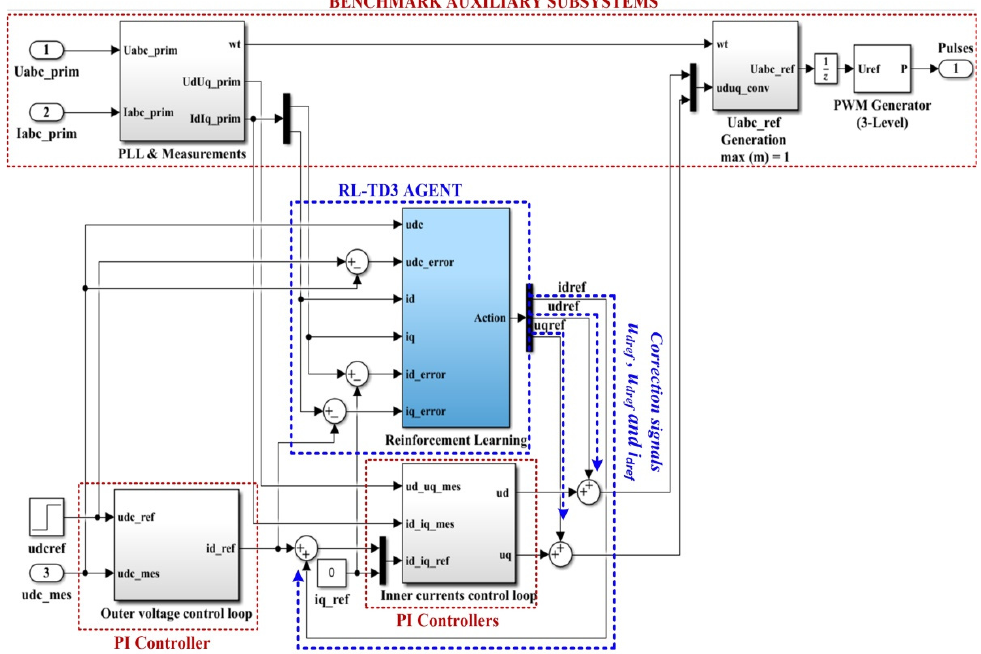
Energies 2022 , 15 , x FOR PEER REVIEW Figure 14. The model MATLAB Simulink implementation of the control system for the GC-PV array based on PI controllers using the RL-TD3 agent for the correction of the u dref , u qref and i dref commands.